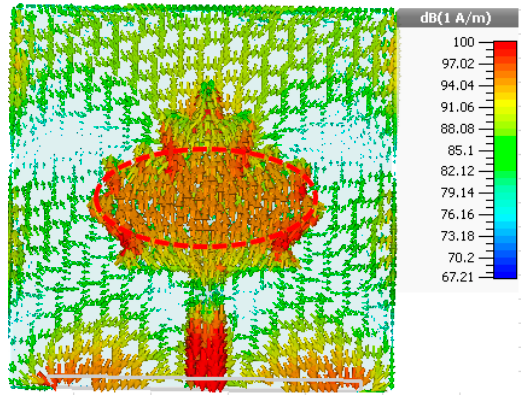
Figure 10. Electric field surface plot of the maple-shaped nano-antenna.